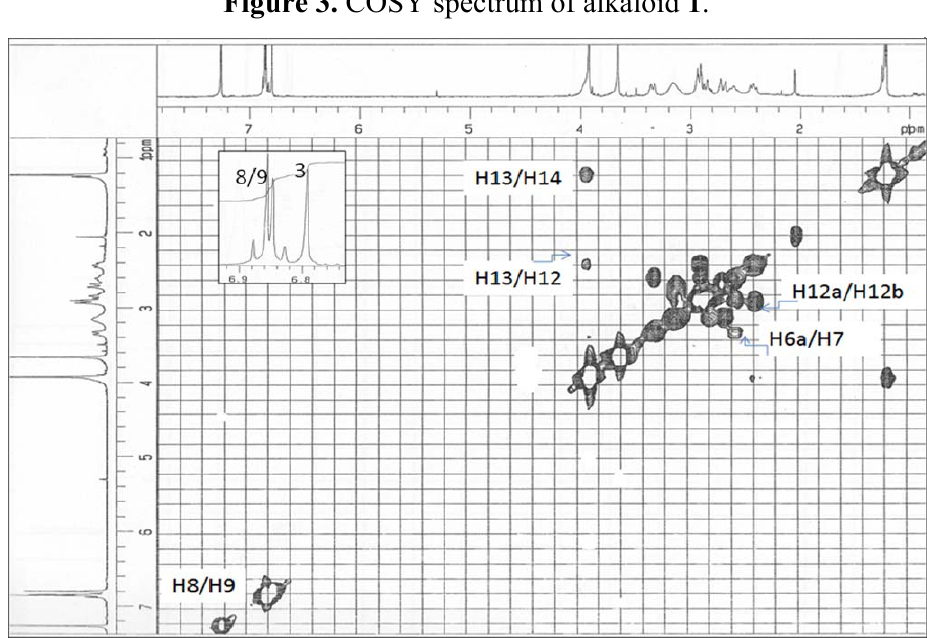
Figure 3. COSY spectrum of alkaloid 1